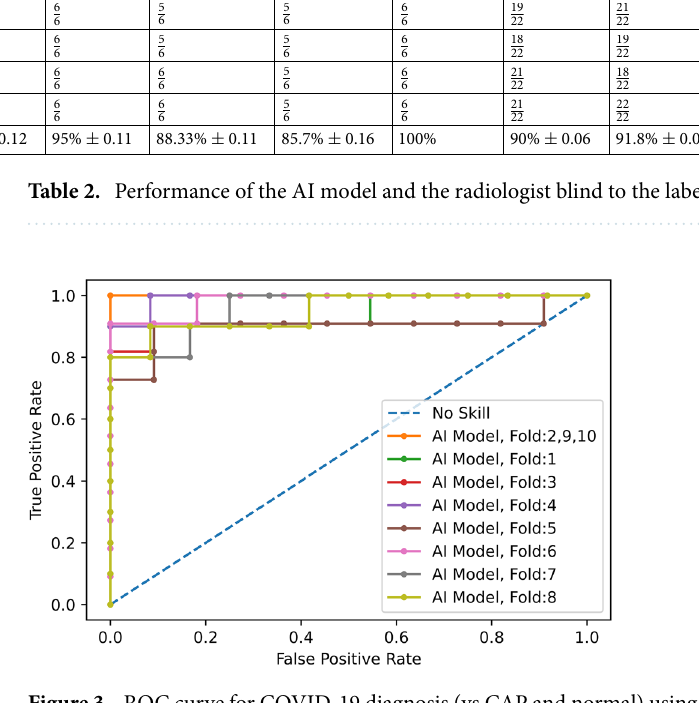
the clinical data. The dataset is randomly split into 10 equal size test sets, leading to 10 sets each including 22 cases. We made sure that each set contained 10% of the COVID-19, CAP, and normal cases, leading to 10 or 11 COVID-19, 6 CAP, and 5 or 6 normal cases in each test set. The AI model is trained 10 times, setting one of the test sets aside and using the rest for training. Averaging over the 10 folds, the slice-level classifier in the first stage achieved accuracy of 89.88% , sensitivity of 88.24% , and specificity of 92.01% , in detecting the slices with infection. Using only CT scans, we evaluated the developed deep learning model and compared it with the fourth tho- racic radiologist, as shown in Table 2. Averaging over all the 10 folds, AI model achieves COVID-19 sensitivity of 89.5% ± 0.11 , CAP sensitivity of 95% ± 0.11 , normal sensitivity (specificity) of 85.7% ± 0.16 , and accuracy of 90% ± 0.06 . The radiologist, on the other hand, achieves COVID-19 sensitivity of 89.4% ± 0.12 , CAP sensitivity of 88.33% ± 0.11 , normal sensitivity (specificity) of 100% , and accuracy of 91.8% ± 0.07 . We tested the hypoth- esis of the AI model and radiologist having the same performance, in term of accuracy, using a McNemar 23 test with the significance level of 0.05, leading to P-values over the significance level for all the 10 folds. The lower specificity of the AI model conforms the non-specific COVID-19 findings 24 . COVID-19 sensitivity versus one minus specificity is plotted in the receiver operating characteristics (ROC) curve, shown in Fig. 3. Area under the curve (AUC) is 0.96 ± 0.03 . Based on the CT scans only, we analyzed the misclassified COVID-19 cases through all folds (11 cases in total), and studied their relation with the disease severity, coming to the conclusion that 4 out of 11 cases, did not have any related imaging findings, 5 were scored 1 by the three radiologists, one was scored 2, and only one case was scored at 3, which means the developed model is less likely to misclassify severe cases. Neither the developed model nor the experienced radiologist was able to detect the 4 COVID-19 cases without imaging findings, using CT scans only. Furthermore, since the CAP patients come from a different cohort and scanned with a standard dose, we visualized the model’s output for CAP cases, one of which is shown in Fig. 4, using Grad-CAM localization technique. This figure shows that the model is paying more attention to disease-related regions of the image, rather than dose-related ones. We performed the same localization technique on two slices with infection of the same COVID-19 patient, shown in Fig. 5.